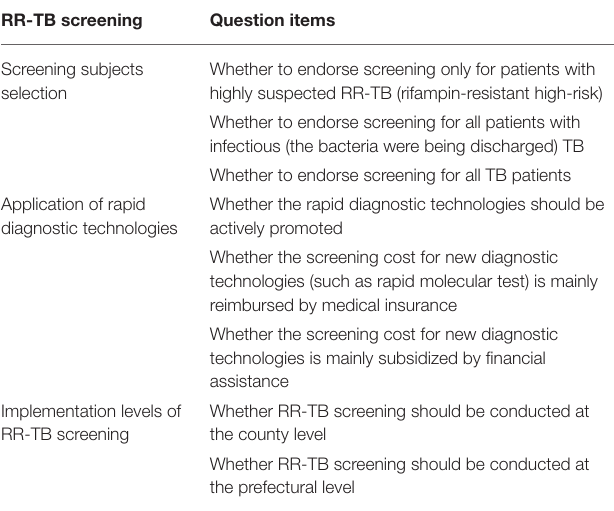
TABLE 2 | Question items involved in RR-TB screening of stakeholders among service providers. RR-TB